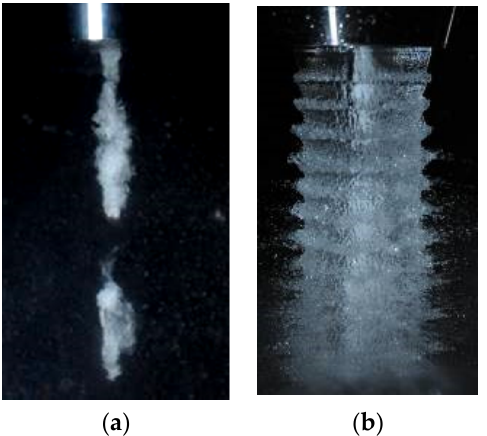
Figure 9. Aspect of cavitating jet in water and in air [54]: ( a ) cavitating jet in water and ( b ) cavitating jet in air.